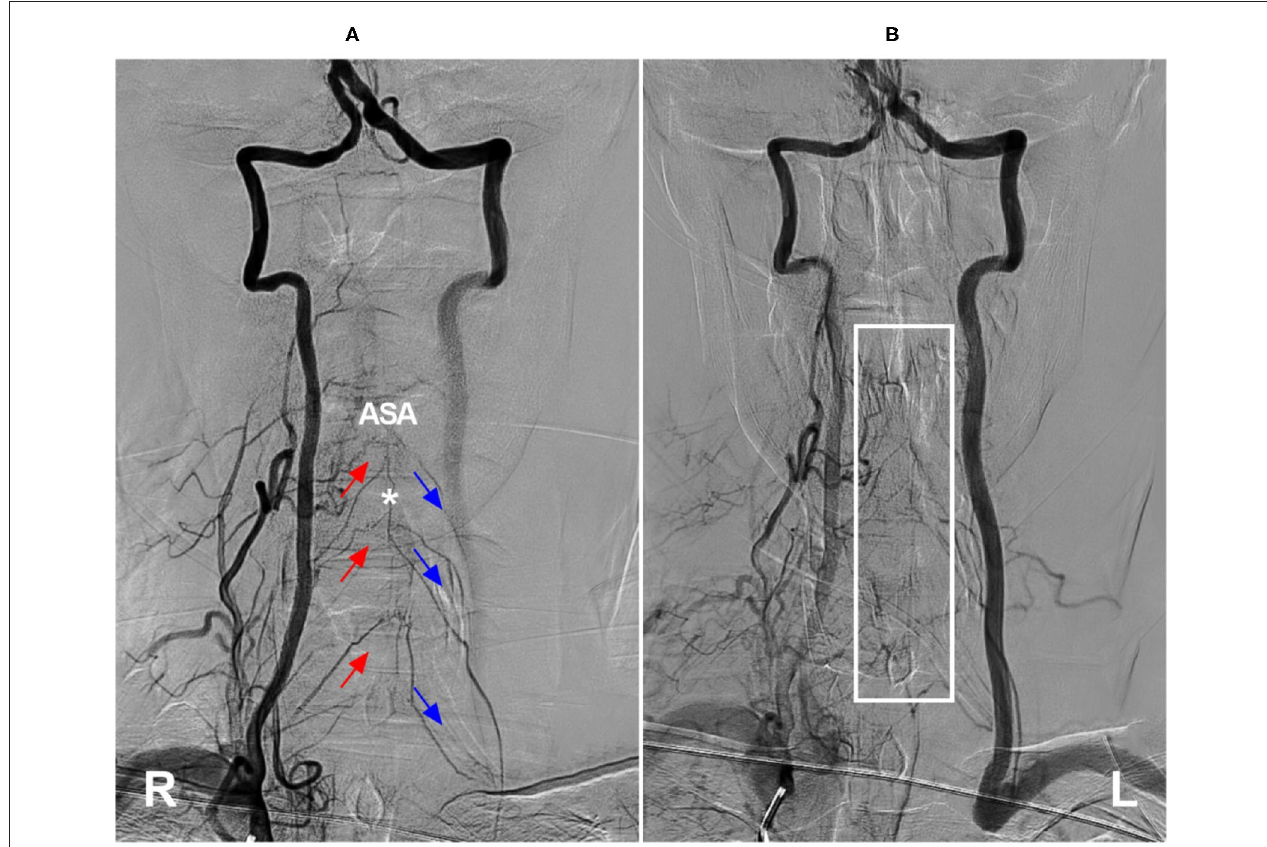
FIGURE 10 | Cervical ASA as a collateral channel in steno-occlusive disease of the subclavian artery. (A) Angiogram of the right VA in arterial phase shows that the compensation of collateral circulation from the right segmental radiculomedullary arteries (red arrows) to the left radiculomedullary arteries (blue arrows) through ASA (asterisk). (B) Angiogram of the right VA in late arterial phase shows the capillary dyeing sign in ASA region (frame). ASA, anterior spinal artery; L, left; R, right; VA, vertebral artery.